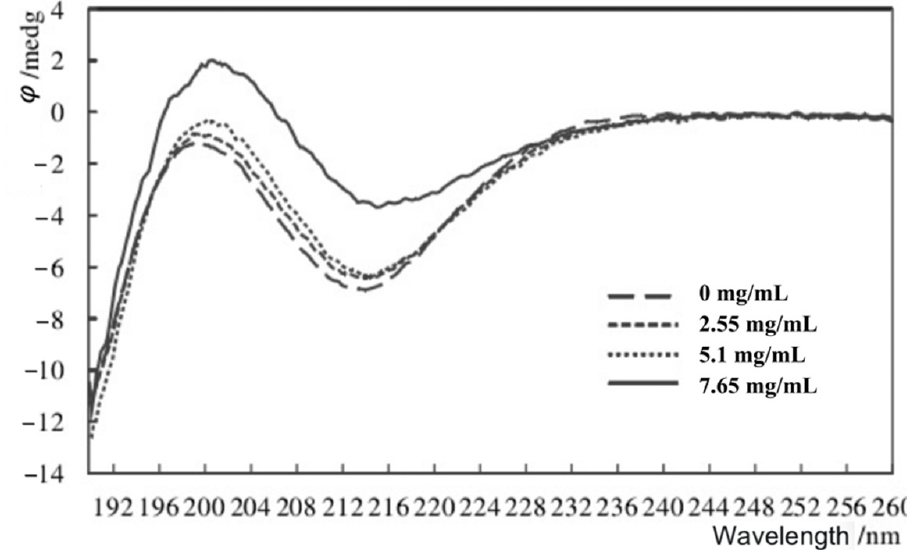
Figure 3. CD spectra of sodium alginate with different concentrations of MGS with the wavelength as the horizontal coordinate and the ellipticity as the vertical coordinate